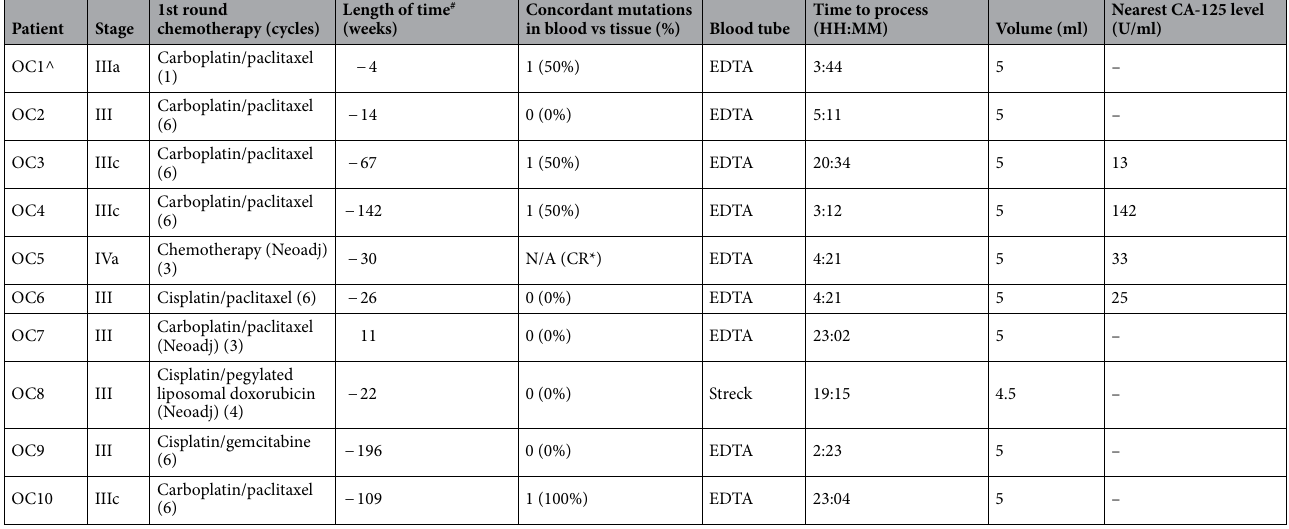
Table 2. Blood collections and timings. N/A not assessable. # Time between blood collection and tissue